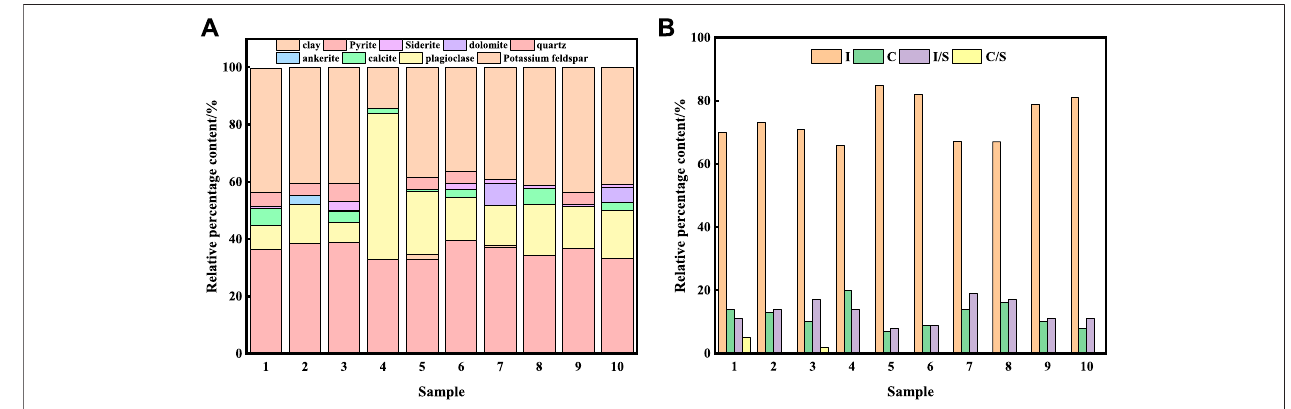
FIGURE 1 | Shale mineral composition. (A) Composition of the whole shale; (B) Clay mineral composition.